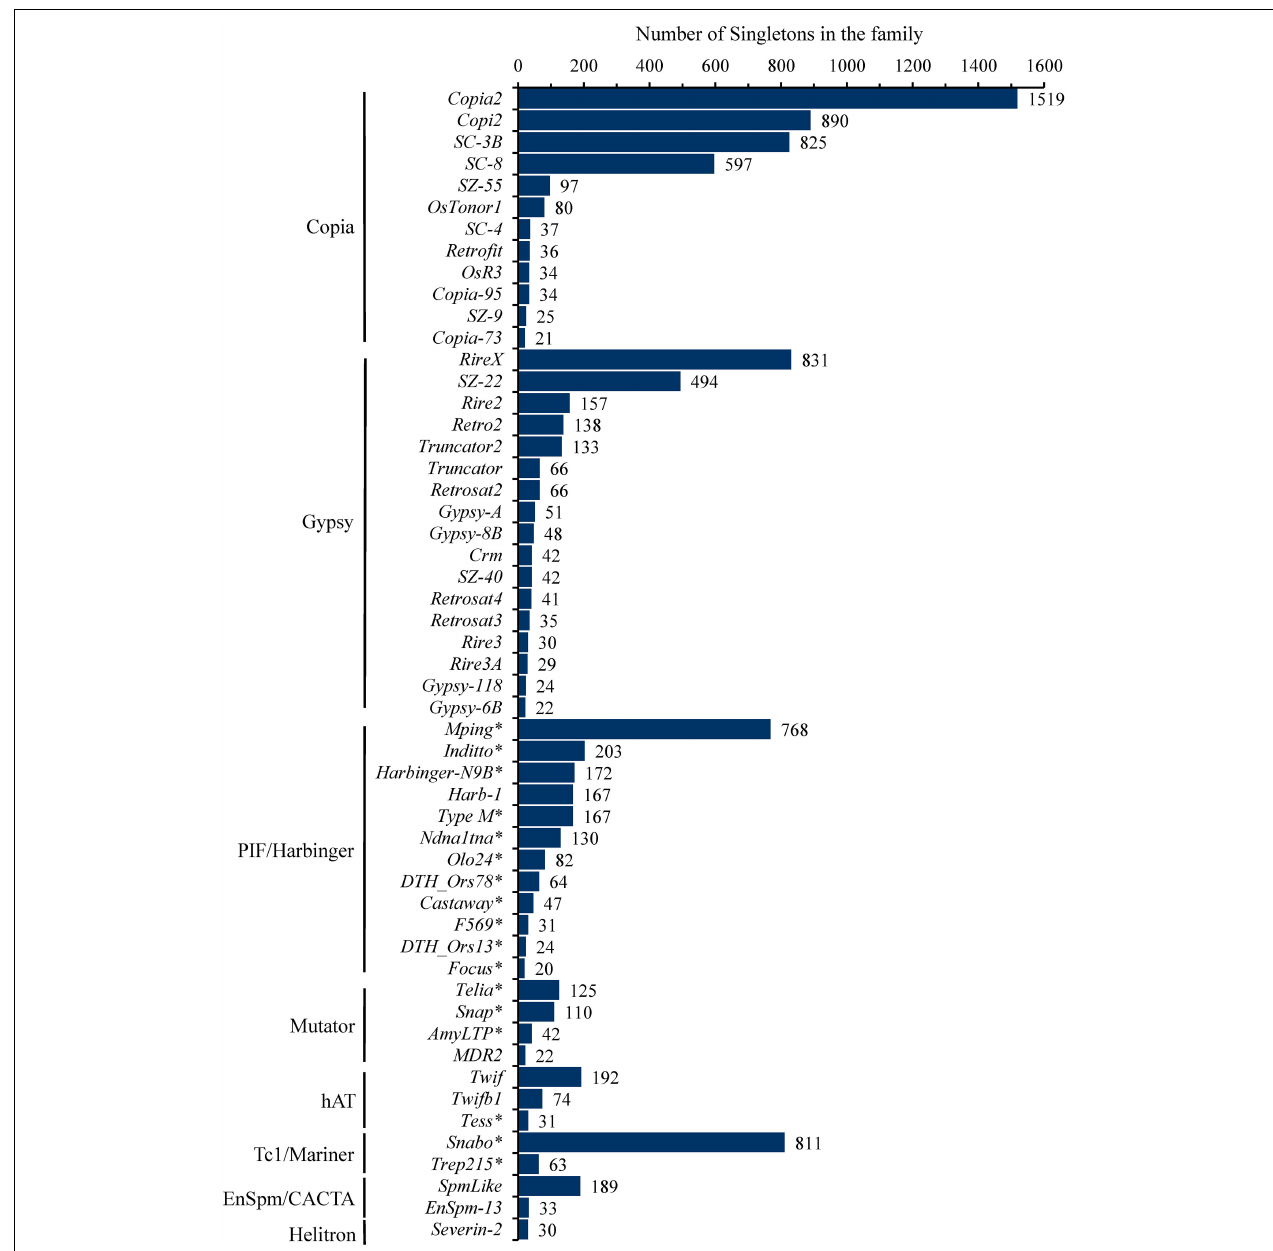
FIGURE 1 | The number of singletons for each TE family. The 52 TE family belong to Copia , Gypsy , PIF/Harbinger , Mutator , hAT , Tc1/Mariner , En/Spm/CACTA , Helitron having more than 20 singletons were shown. Among them, eight families ( Copia2 , Copi2 , SC_3B , SC_8 from Copia ; RireX , SZ_22 from Gypsy ; mPing from PIF/Harbinger ; Snabo from Tc1/Mariner ) harbored at least about five hundred singletons, far more than others, suggesting that they possessed the highest level of current activity in 3,000 natural rice accessions. The asterisk appended to the name of TEs denoted that the corresponding family was also annotated as MITEs.